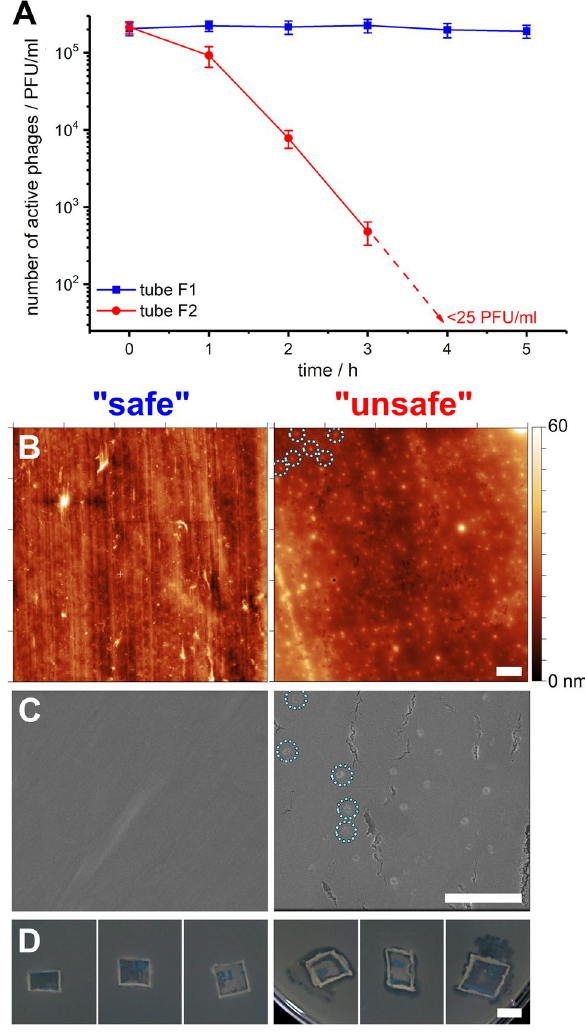
Figure 2. Analysis of surfaces of “unsafe” F2 and “safe” F1 tubes after incubating phages with mixing. ( A ) the number of active T4 phages is related to the surfaces of the tubes. Surfaces were analyzed using ( B ) AFM (E3 and E9) and ( C ) SEM (F1 and F2). Some virions are marked with circles. ( D ) Additionally, a piece of each plastic was placed on bacteria to check adsorbed phages’ infectivity (F1 and F2). Pictures in panels ( B – D ) are shown with their scale bar representing 0.5 µm, 0.5 µm, and 5000 µm, respectively.